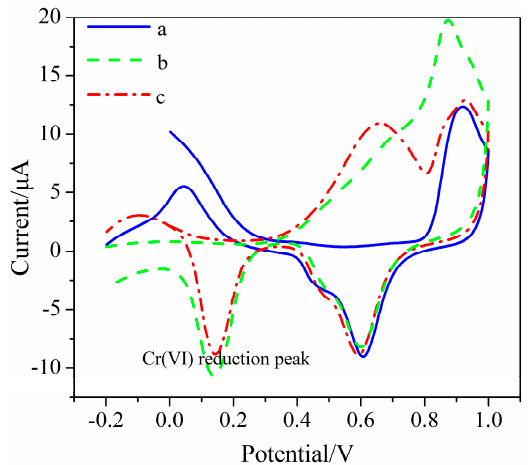
Figure 2. The cyclic voltammetry of the AuNPs–BDD electrode in absence of (a) and in presence of 100 μ mol/L hexavalent chromium (Cr (VI)) in the 1st cycle (b) and 5th cycle (c).